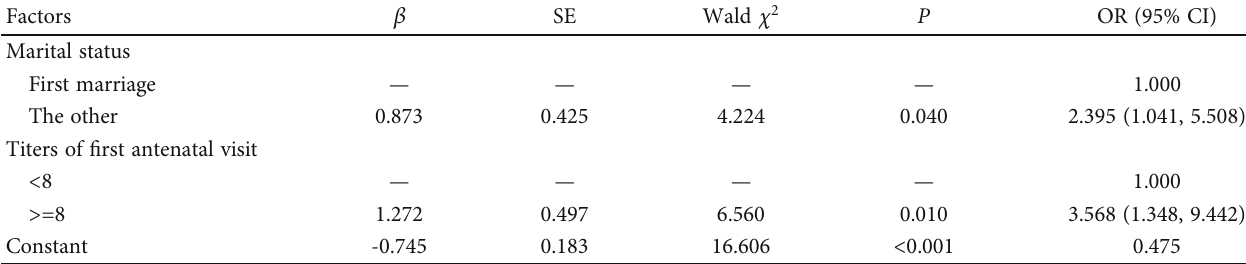
Table 4: Unconditional multivariate logistic regression model analysis of adverse pregnancy outcomes in pregnant women without treatment for